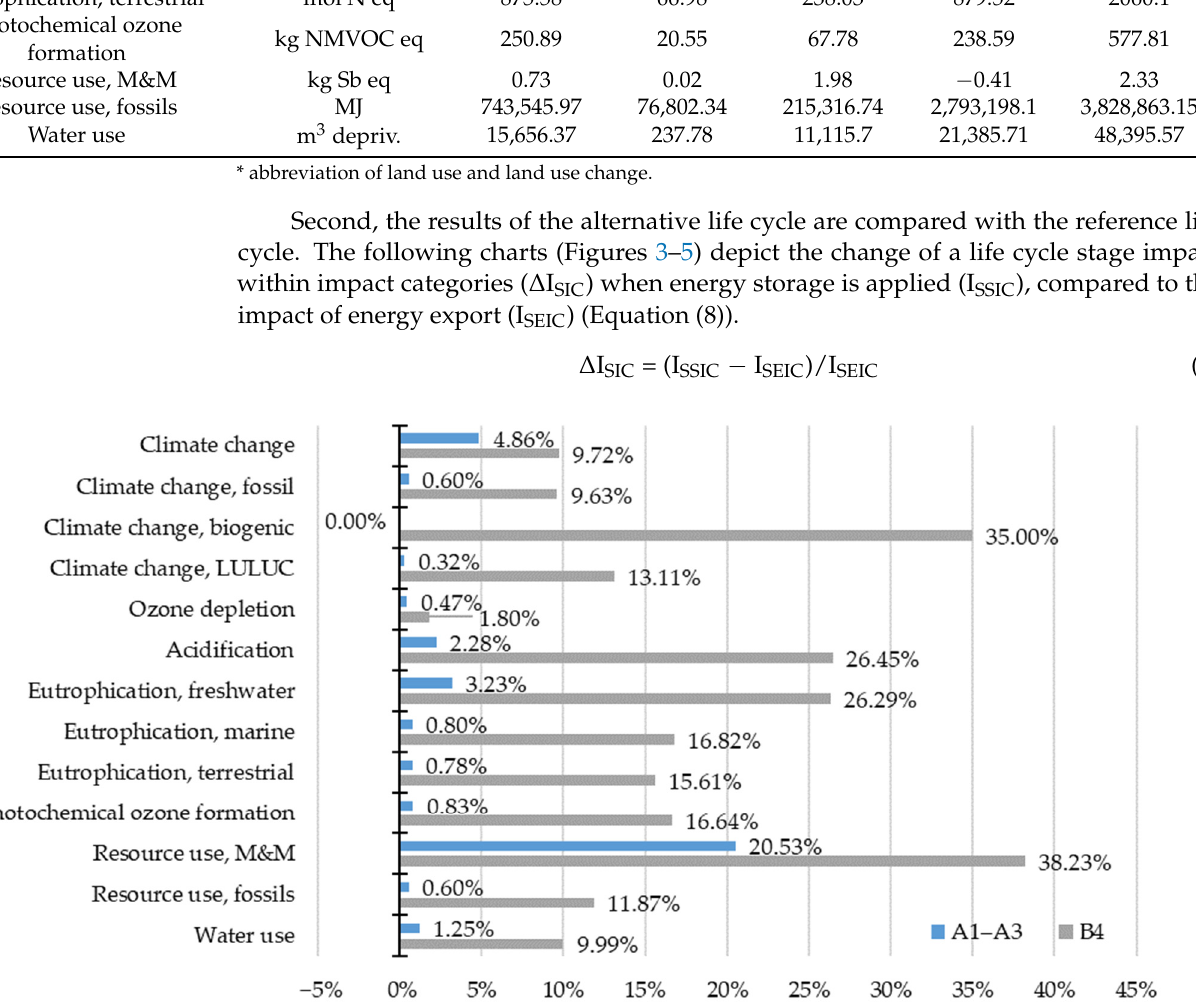
Figure 3. Environmental impact shift of A1–A3 and B4 stages considering photovoltaic energy storage.